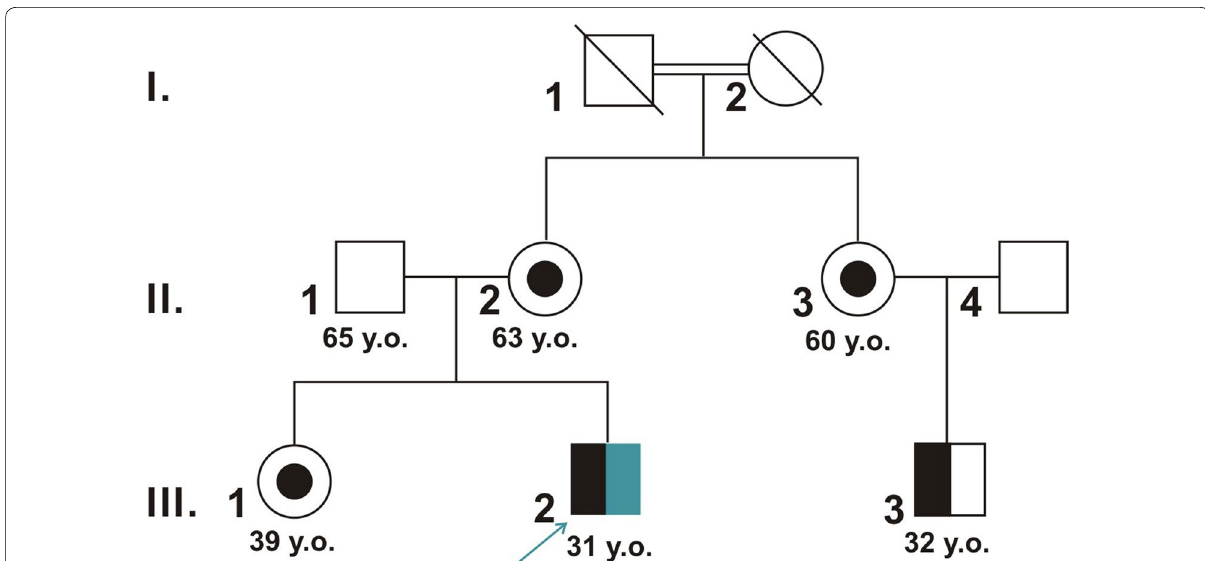
Fig. 1 Pedigree of the family. Squares indicate males, and circles represent females. Slashed symbols indicate deceased individuals. Unfilled symbols indicate unaffected individuals. Black dotted circles indicate unaffected individuals carrying the androgen receptor ( AR ) gene mutation. Half-black shaded symbols represent individuals carrying the AR gene mutation who are affected by partial androgen insensitivity syndrome (PAIS). The blue arrow indicates the proband. The half-blue shaded symbol indicates that the proband presented with colorectal cancer (CRC). y.o. indicates the age at the time of the analysis. The proband developed primary CRC at 27 years old, metachronous CRC at 30 years old, and recurrent CRC at 31 years